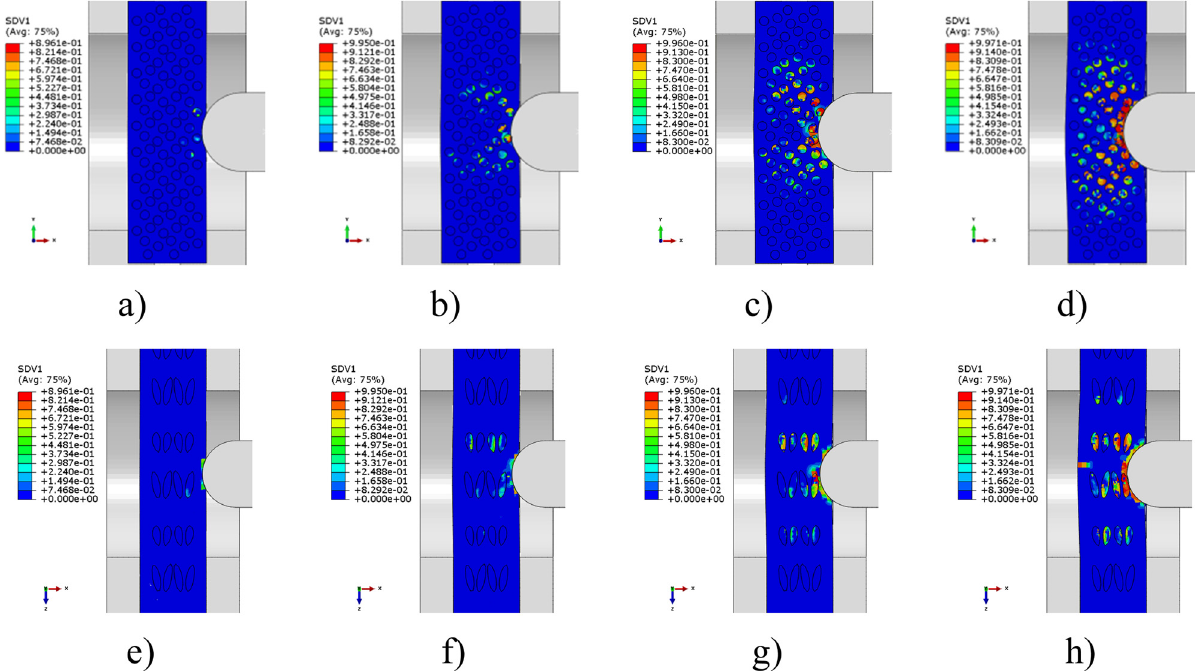
Figure 15: Longitudinal tensile damage of fi ber bundles and matrix: ( a – d ) damage expansion process at beginning, middle, late, and end of fi ber bundles; ( e – h ) damage expansion process at beginning, middle, late, and end of matrix.